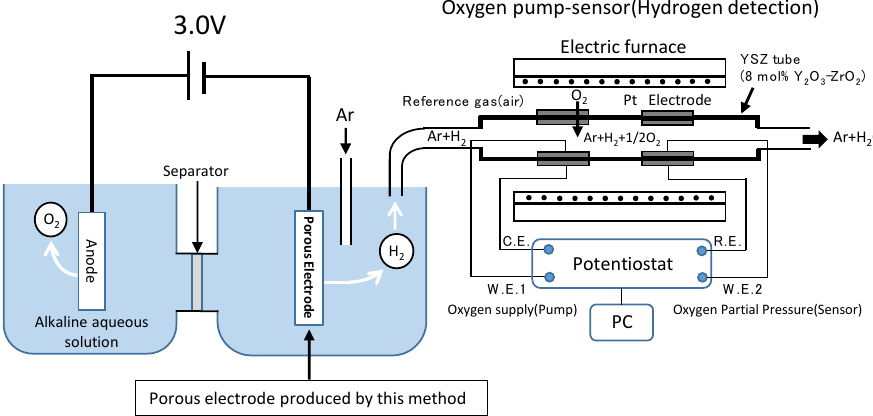
Figure 2. Schematic diagram of hydrogen generation amount measuring device by alkaline water electrolysis.